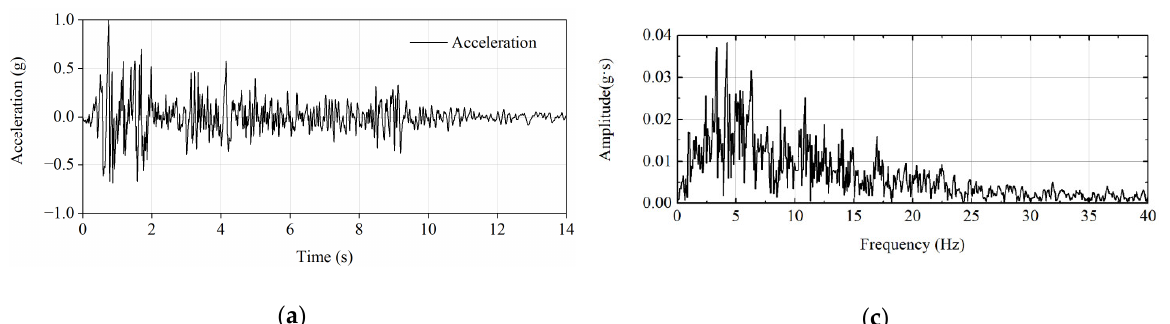
Figure 6. Characteristics of the input wave: ( a ) time history curve of acceleration; ( b ) time history curve of displacement; ( c ) acceleration Fourier spectrum curve.